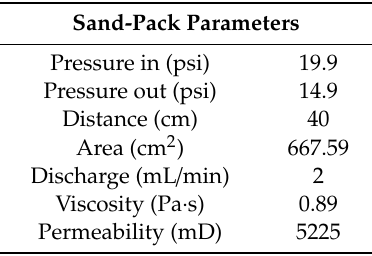
Table 3. The parameters used to calculate the pressure drop and